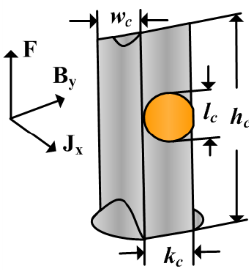
Figure 5. Variables of the pump in the central channel.